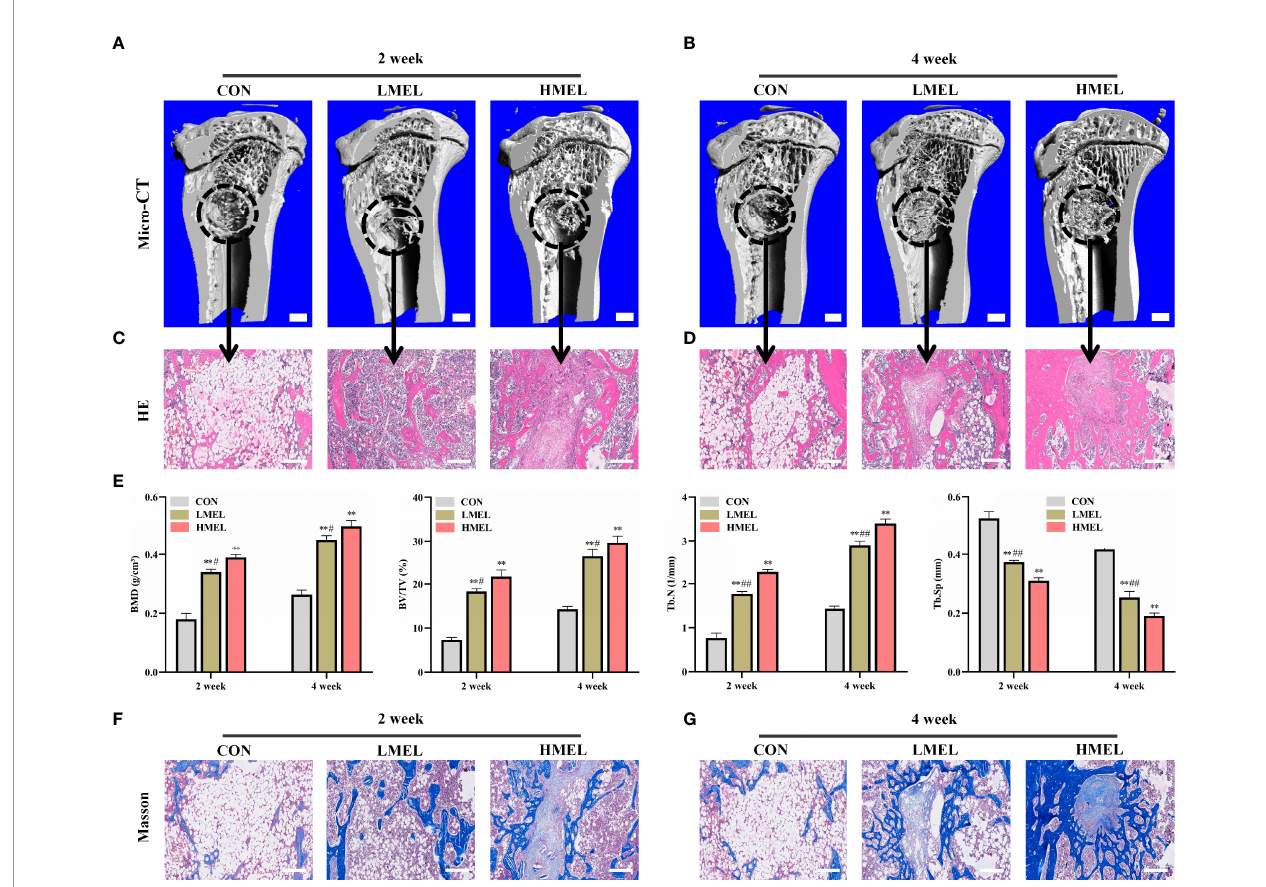
FIGURE 5 | Melatonin enhanced the bone repairing ability by promoting osteogenesis of tibia defect in ovariectomized rats. (A, B) 3D images of mineralized bone formation in tibia defect (scale bars, 1 mm). (C, D) Histological assessment of the defect area by H&E staining (scale bars, 200 m m). (E) Quantitative presentation of microarchitectural parameters, including BMD, BV/TV, Tb.N, and Tb.Sp. (F, G) Histological assessment of the defect area by Masson ’ s trichrome staining (scale bars, 200 m m). BMD, bone mineral density, BV/TV, trabecular bone volume, Tb.N, trabecular number; Tb.Sp, trabecular separation; HMEL, high-dose melatonin treatment group. The data are presented as means ± SEM. ** p < 0.01 vs . control group, # p < 0.05, ## p < 0.01 vs . HMEL